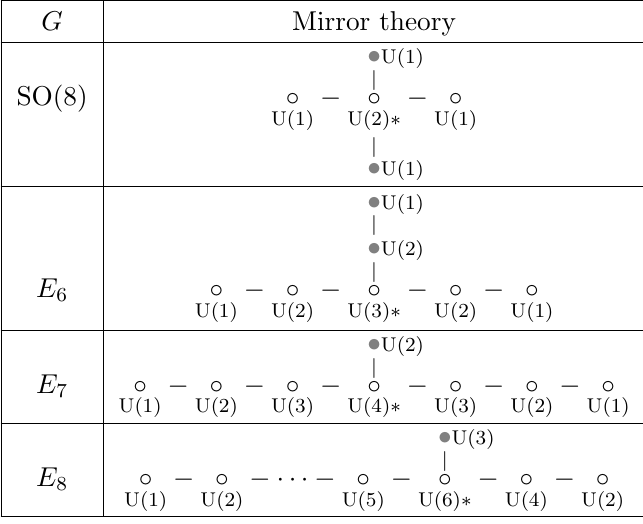
Table 2 . Three dimensional mirror theory of the T 3 compacti(cid:12)cation of the theory on a single M5- brane on the completely frozen C 2 = (cid:0) G singularity. Here U( N ) (cid:3) denotes U( N ) = U(1) (cid:24) = SU( N ) = Z N